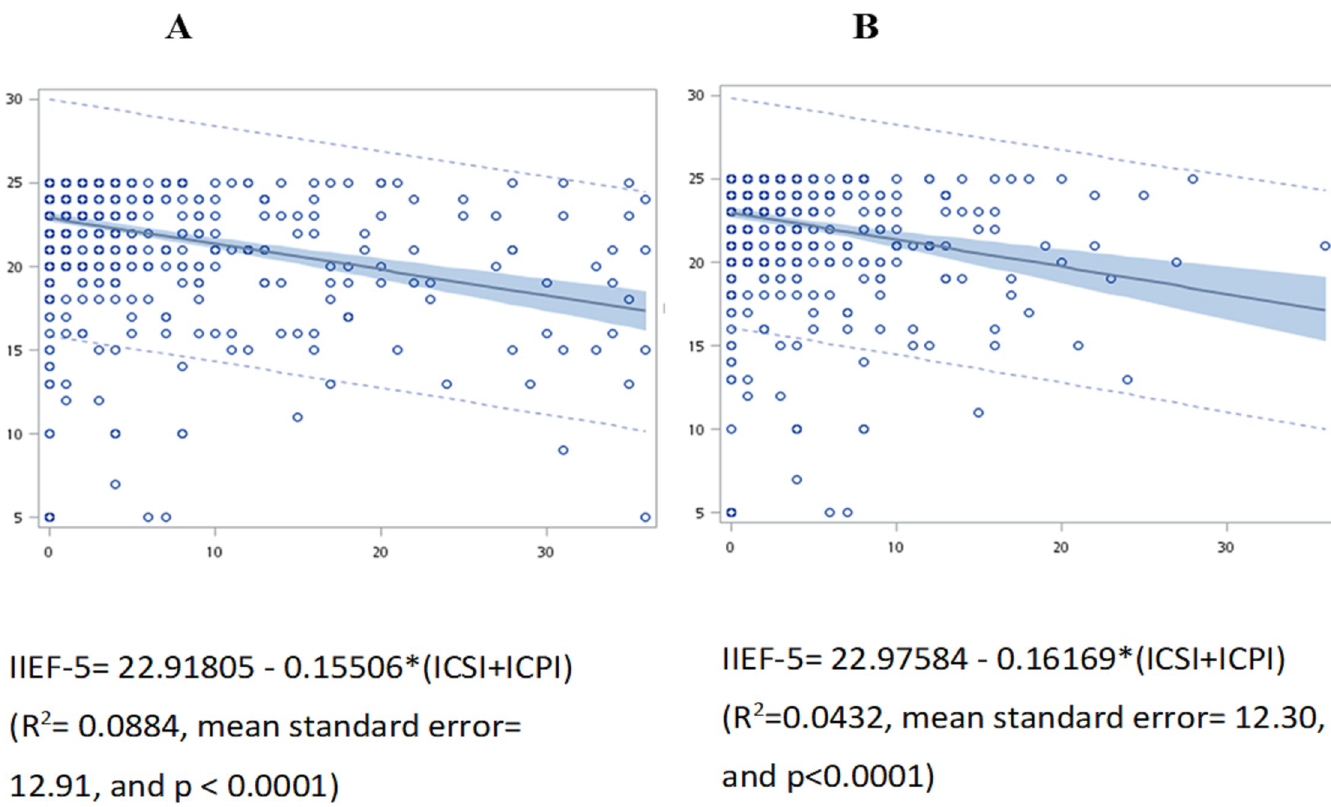
Fig 1. Correlations between sexual (IIEF-5, Y axis) and bladder dysfunction (ICSI+ICPI, X axis) in 734 male street and hospital ketamine abusers (1A) and 681 street ketamine abusers (1B).